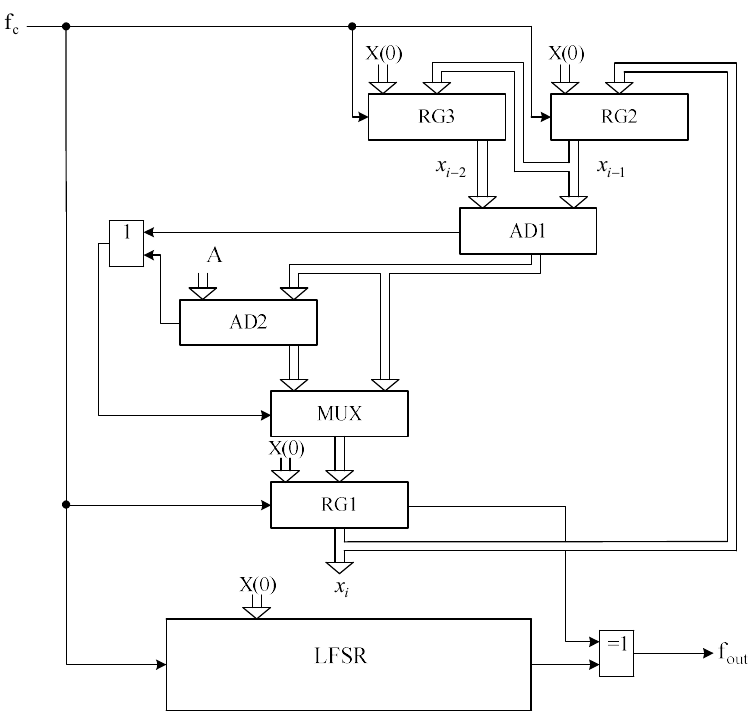
Figure 4. Structure scheme of the combined PRBSG.